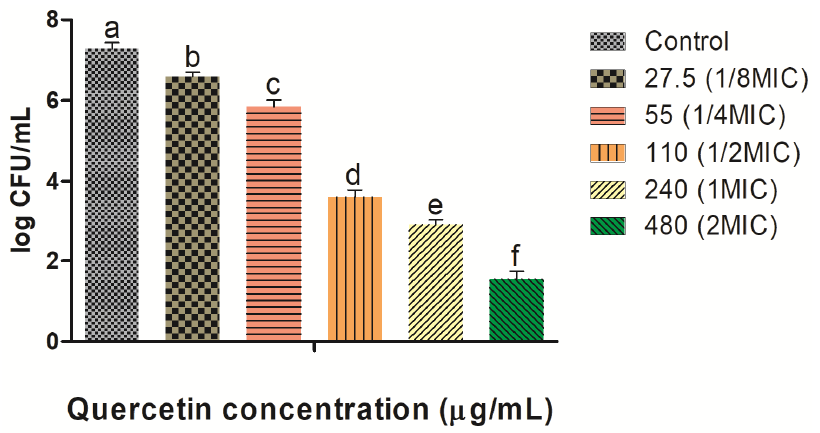
Figure 1. Effects of quercetin against Vibrio parahaemolyticus planktonic cells with different concentra- tions ( µ g/mL) were used in this study. Data are represented as mean ± SEM of three independent replicates. a–f Values with different letters differ significantly different by Duncan’s multiple-range test ( p < 0.05).